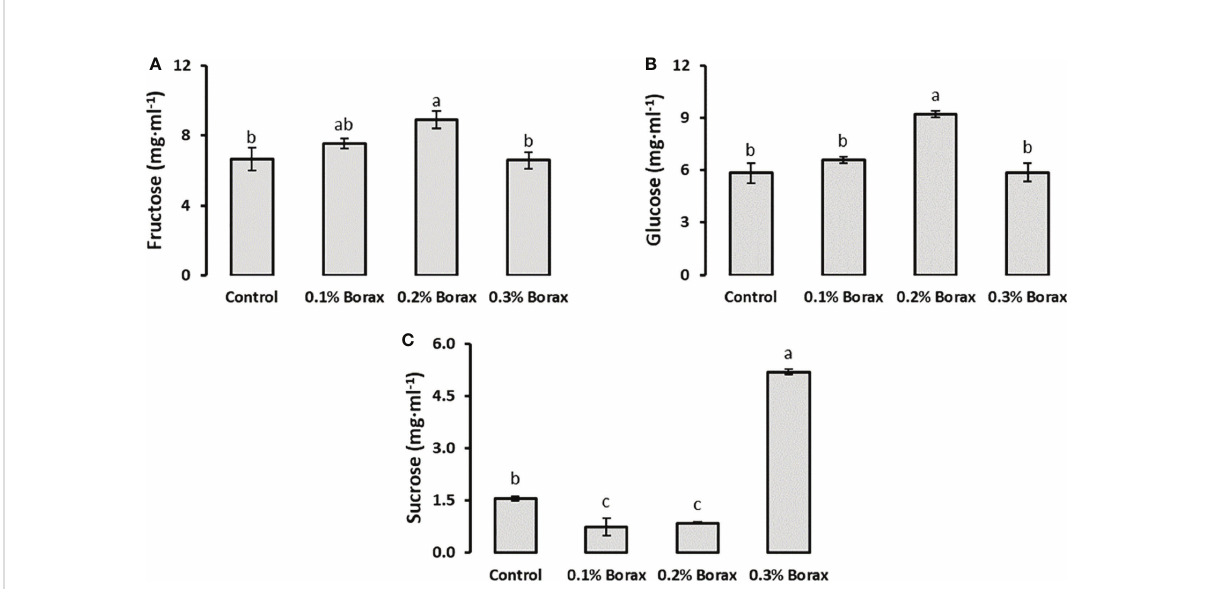
FIGURE 3 Effect of foliar application of B on soluble sugars i.e., fructose (A) , glucose (B) , and sucrose (C) content of loquat fruits. Same letters indicate non-signi fi cant difference among treatments according to Fisher ’ s least signi fi cant difference (LSD) test, when p ≤ 0.05 . Vertical bars indicate mean ± standard error (n=4, 4-block RCBD arrangement).